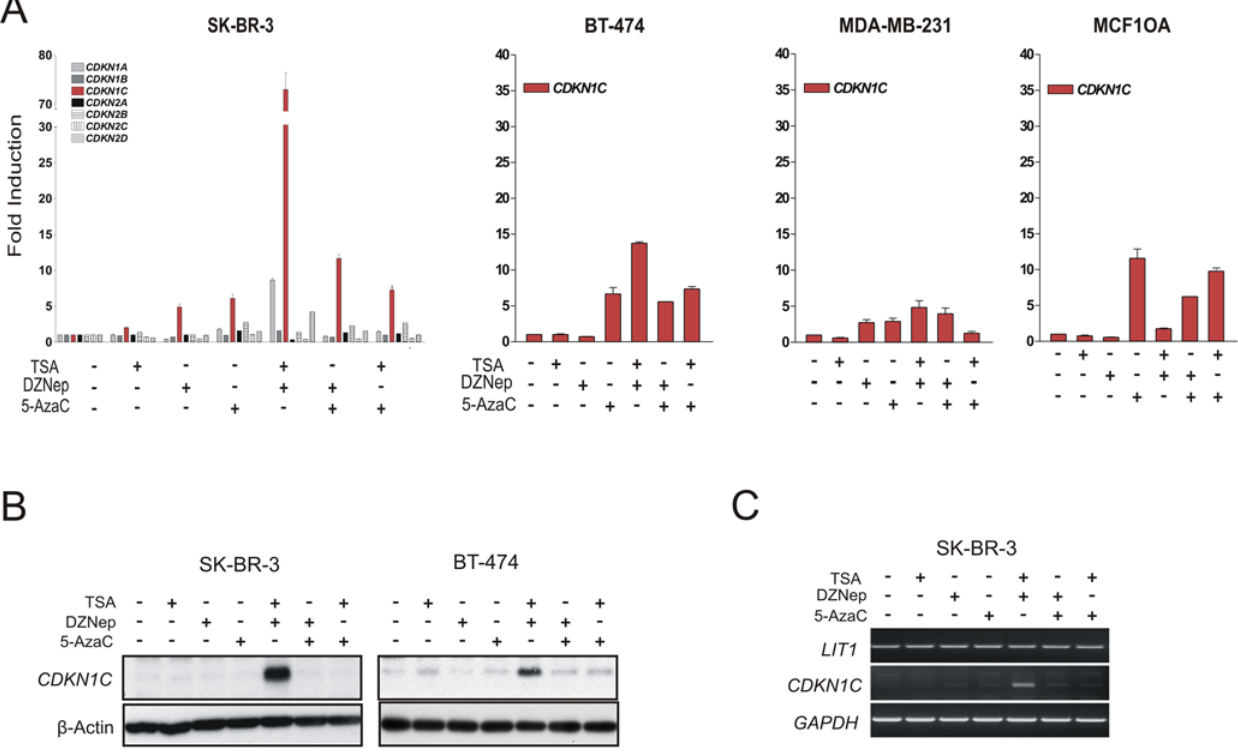
Figure 3. Changes of CDKN1C expression in response to DZNep, TSA, Aza and their combinations. (A) SK-BR-3, BT-474, MDA-MB-231 and MCF10A cells were treated with 5 m M DZNep (D), 100 nM TSA (T), and 5 uM 5-AzaC (A) along or in indicated combinations. Expression of CDKN members were analyzed by quantitative RT-PCR. Shown were the folds of induction relative to the untreated cells. (B) Western blot analysis of CDKN1C protein expression in SK-BR-3 and BT-474 cells. (C) RT-PCR results show no change of LIT1 expression upon indicated drug treatment. .